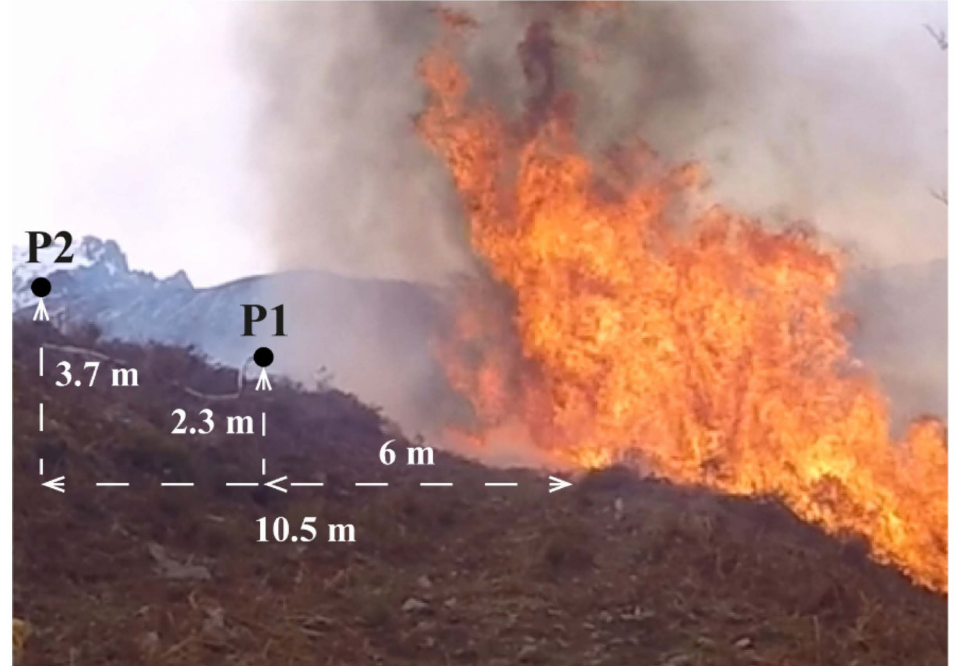
Figure 11. Positions P1 and P2 of the radiant and total fluxmeters with respect to the plot end (March 2022 experiment).